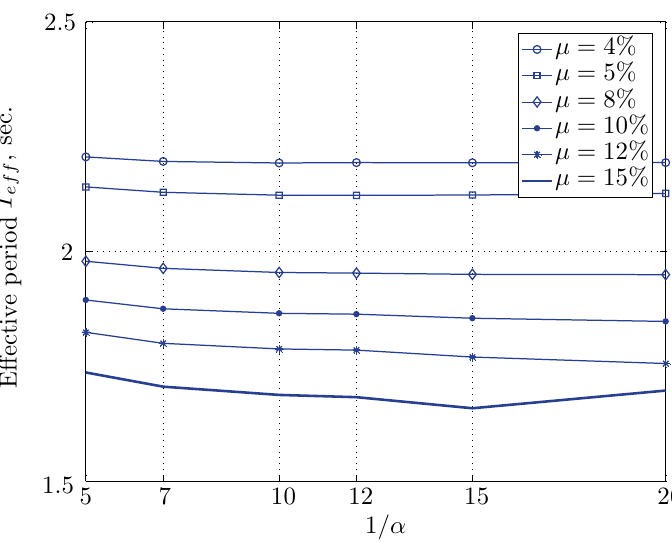
Figure 25. Effective period for various isolation system parameters (Lexington dam).